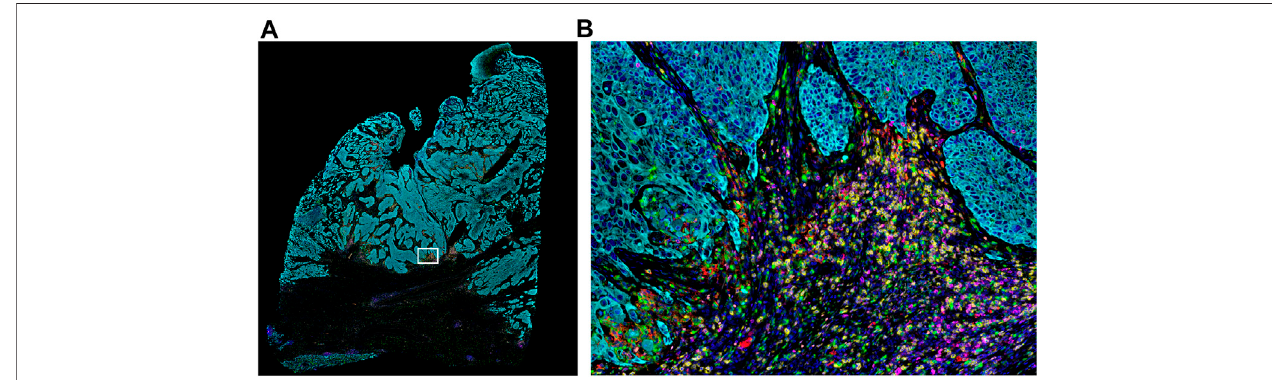
FIGURE 2 | Whole-slide MOTiF image of lung cancer FFPE tissue. (A) Markers stained for this 6-plex, 7-color assay include CD8 (yellow), PD-L1 (red), FoxP3 (orange), PD-1 (magenta), cytokeratin (cyan), and CD68 (green). White box indicates (B) selected areafrom whole tissue section image at 20 × magni fi cation highlighting the interactions between the immune system and the tumor (i.e., “ hotspot ” ). The cellular composition and distribution reveal immune engagement with the tumor, evidenced by tumor-in fi ltrating lymphocytes (TILs), PD-L1+ macrophages, PD-L1 − tumor cells, and an abundance of para-tumoral regulator T-cells and cytotoxic T-cells, including several that are PD-1+. Elucidating the interplay between these different cell types is key to understanding the variance in patient responsiveness to therapeutic treatments.